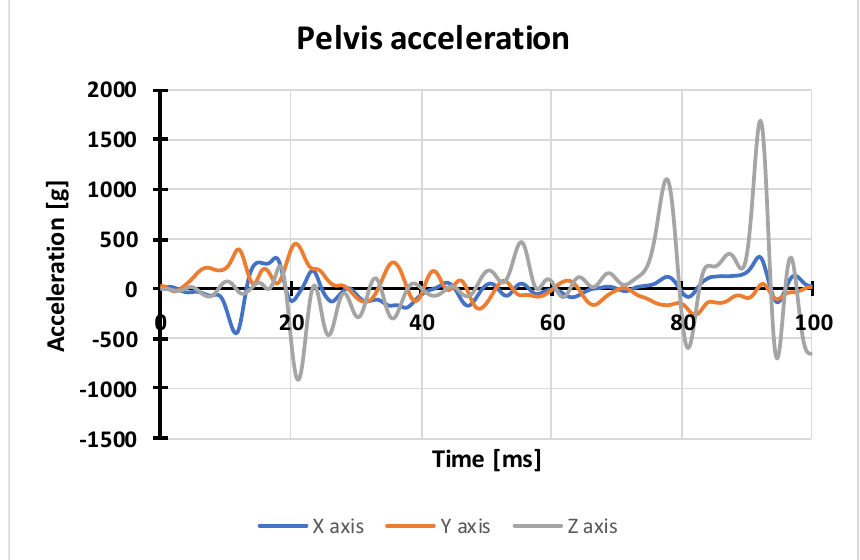
Figure13. Figure 13. Characteristic of acceleration in the dummy's pelvis obtained on the basis of numerical calculations.